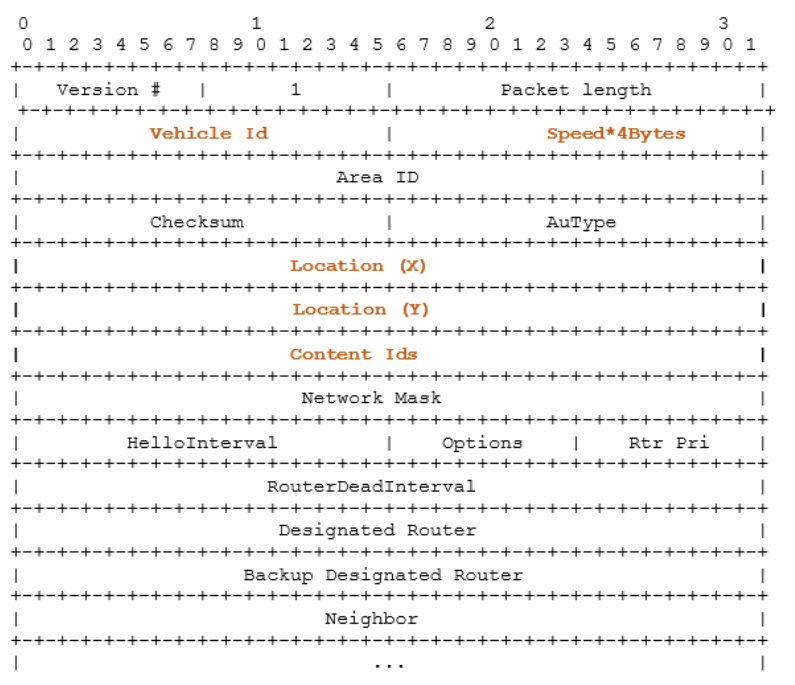
Figure 2. Multihead selection-scheme-extended hello packet.